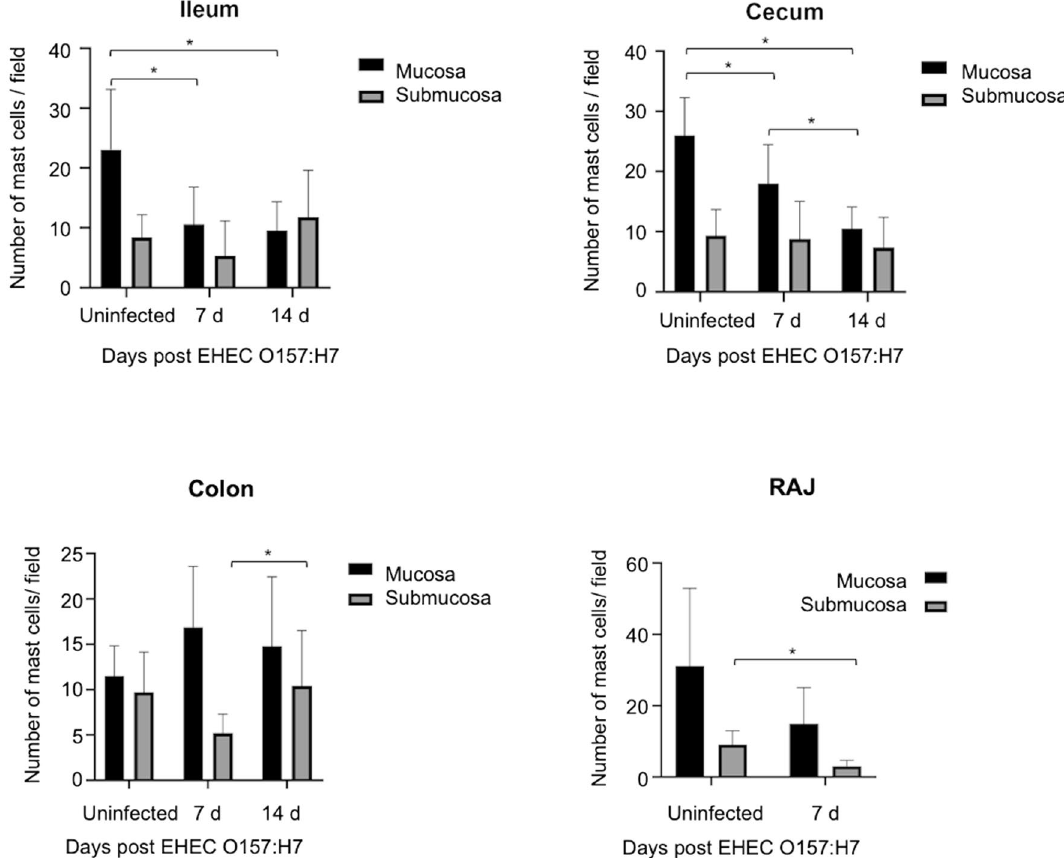
Figure 7. Quantification of mast cells in the mucosa and submucosa of ileum, cecum, colon, and rectal anal junction (RAJ) of calves challenged by EHEC O157: H7 (7 d and 14 d post-challenge). Mast cells were identified by toluidin blue staining (see Sup Fig.